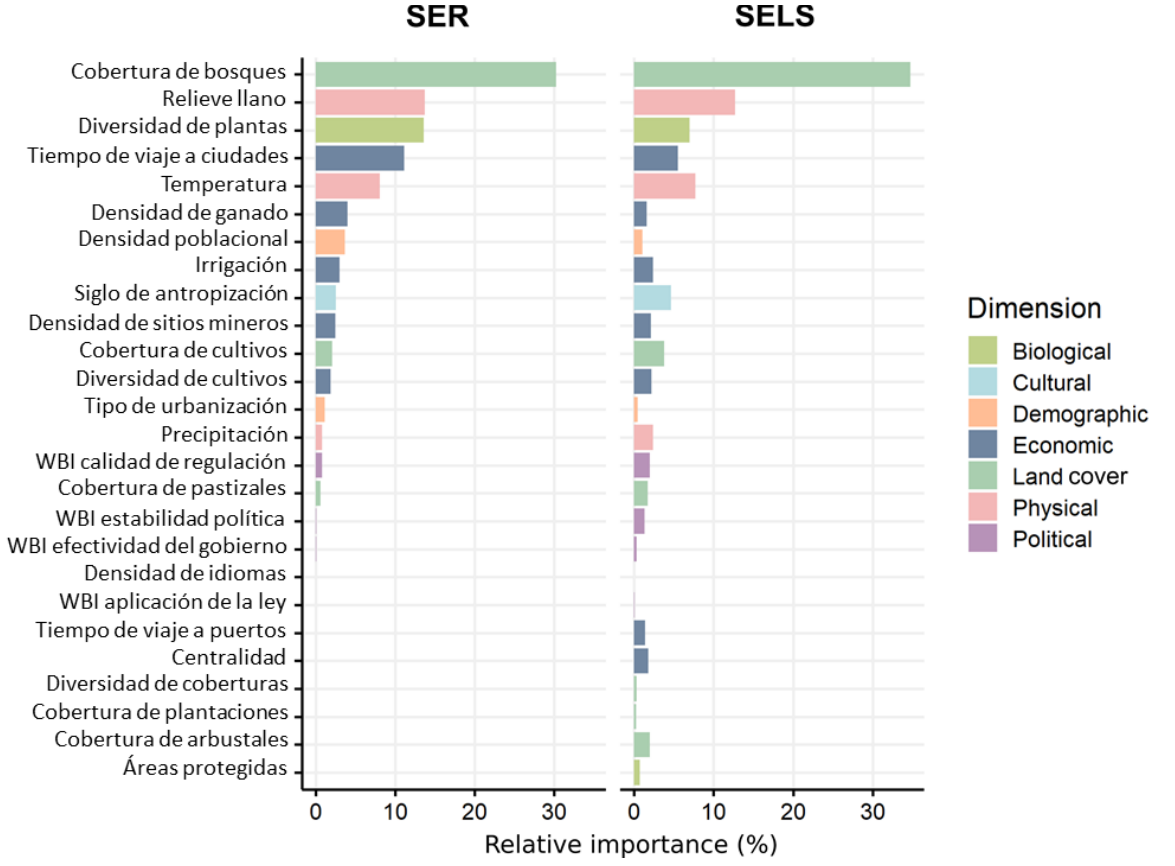
Figura 2. Gráficos de importancia relativa para los SER (izquierda) y SELS (derecha). Los valores indican el porcentaje de la contribución de las variables para cada uno de los dos modelos de clasificación generados a través de árboles de regresión independientes. Los colores de las barras indican a qué dimensión pertenecen las